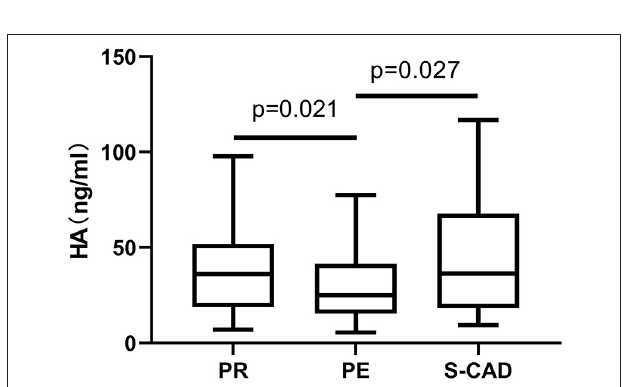
FIGURE 4 | Relations of plasma HA levels among patients with PR, PE, and S-CAD. HA, hyaluronan; PR, Plaque Rupture; PE, Plaque Erosion; S-CAD, Stable Coronary Artery Disease.